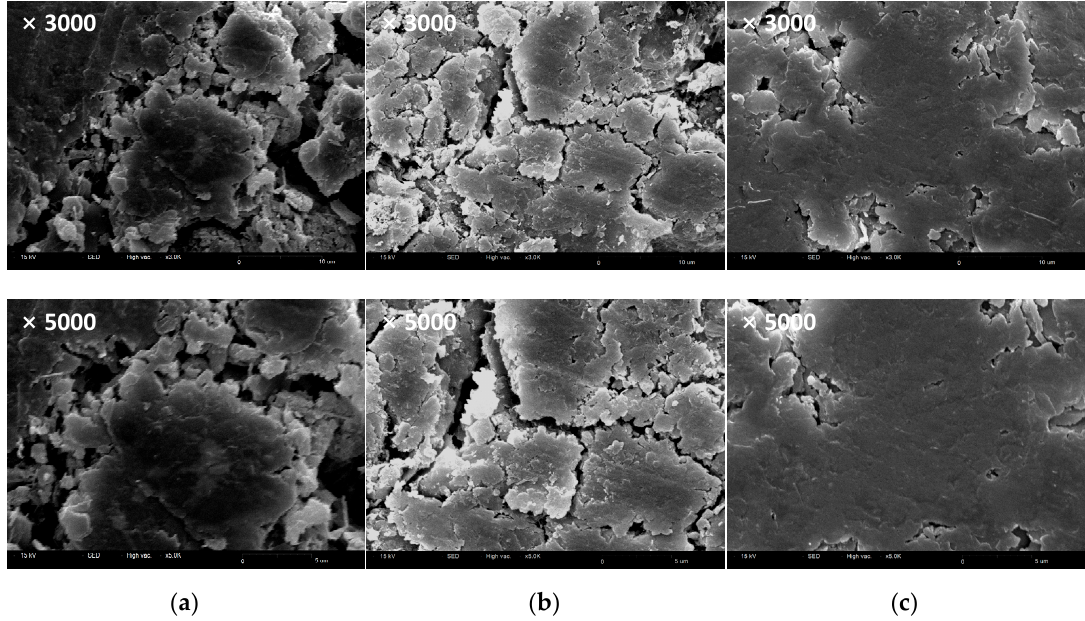
Figure 6. SEM micrographs of ( a ) RP, ( b ) RPC, and ( c ) RPE specimens at 24 h (scale bar: ×3000, 10 µm; ×5000, 5 µm).